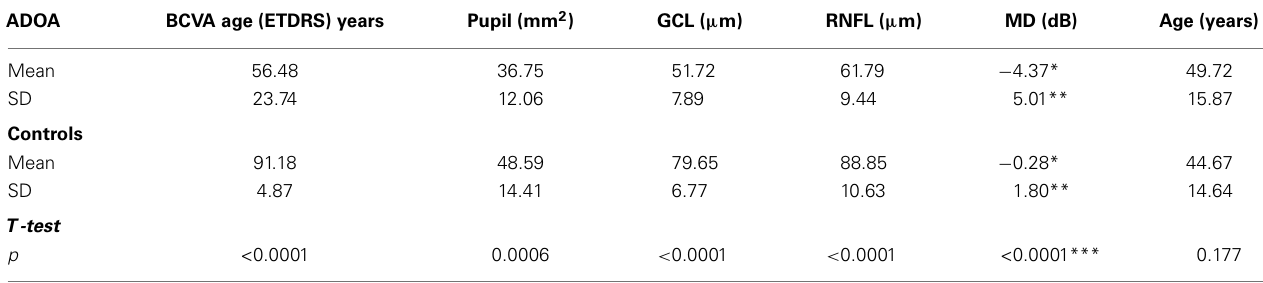
Table 1 | Distribution of best corrected visual acuity (BCVA) as measured in the ETDRS system, baseline pupil area (Pupil), average macular ganglion cell and inner plexiform layer thickness (GCL), average peripapillar retinal fiber layer thickness (RNFL), mean deviation in visual field analysis (MD), and age ofADOA patients and controls